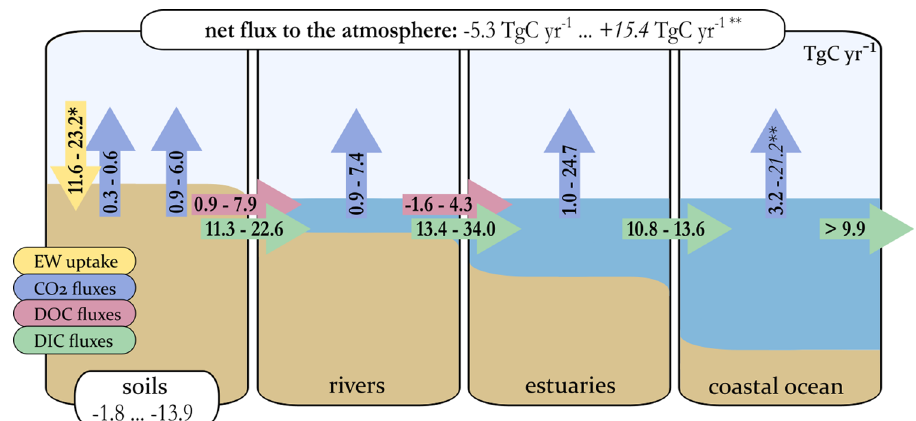
Fig. 5 Overview of changes in the carbon fl uxes from Sumatra caused by enhanced weathering. Fluxes are presented in TgC year − 1 . Blue values represent fl uxes in form of CO 2 , while red and green values represent DOC and DIC fl uxes, respectively. Values in white boxes represent the net change in soils and the atmosphere. *The soil uptake is represented by published EW estimates 8,9 . **The upper bound of coastal ocean emissions is likely overestimated due to the simpli fi ed mixing calculations as explained in the